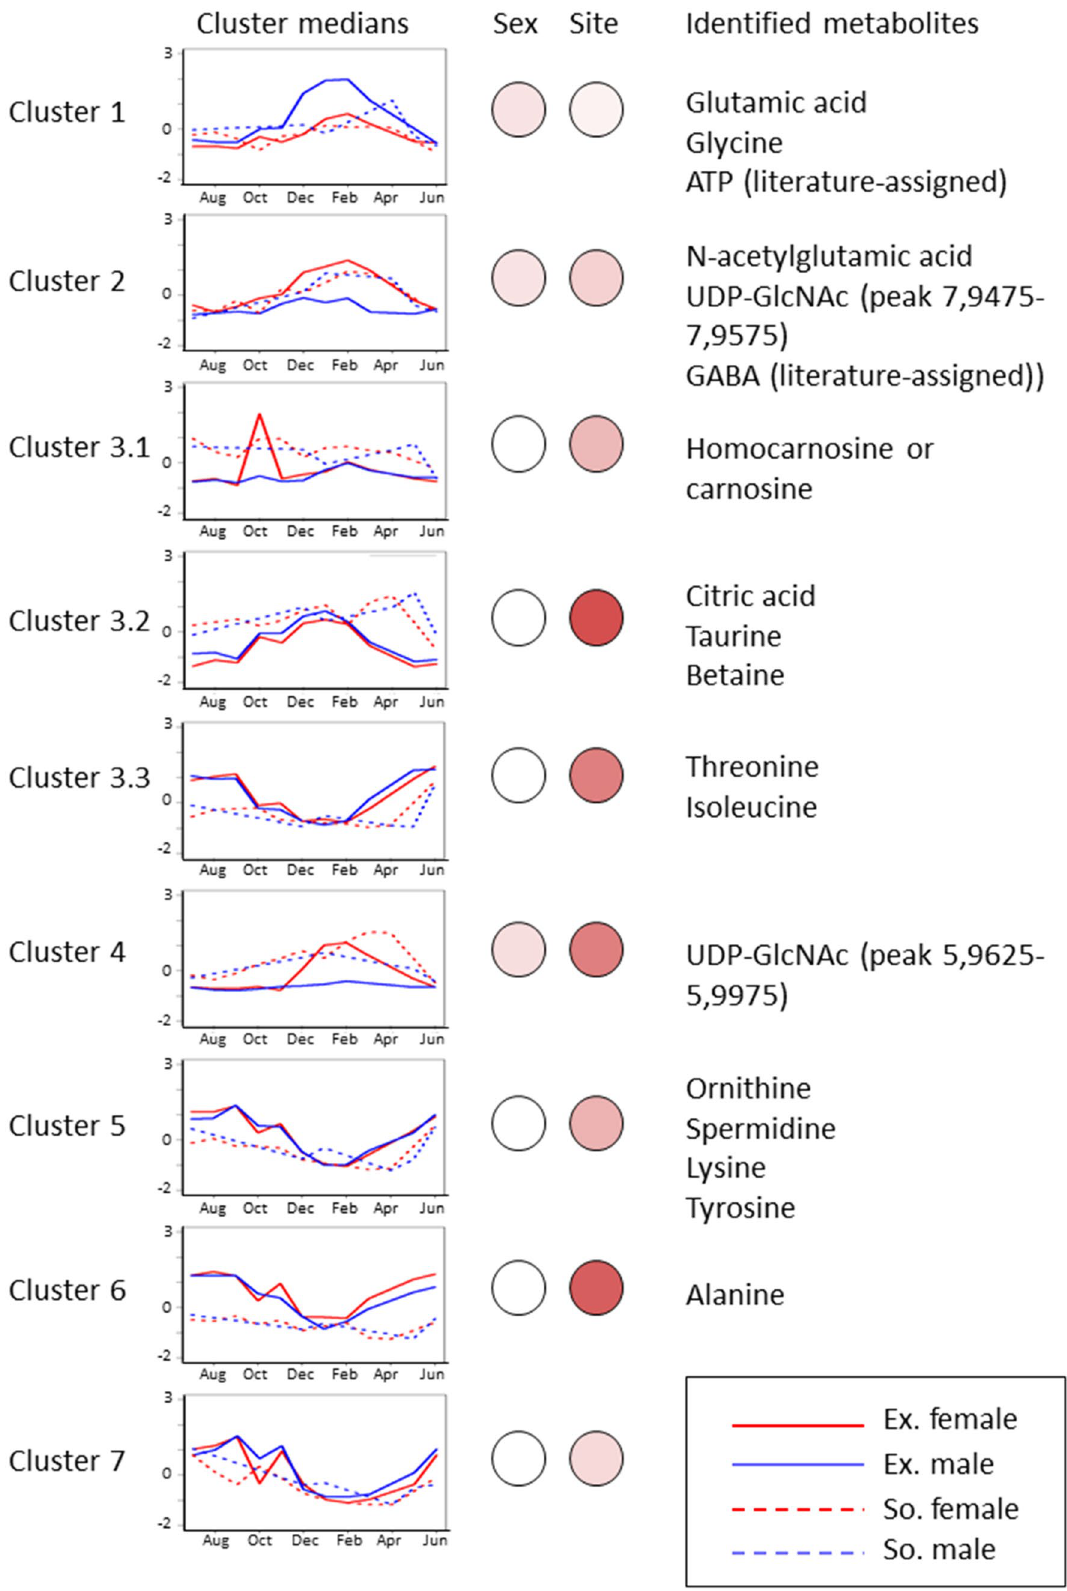
Figure 3. Clustering of metabolic profiles. Metabolite bins of Exmouth mussels have been clustered with HOPACH, a clustering tool that determines the number of clusters automatically. Cluster medians are used for visualization. The same Exmouth clusters are used to show cluster medians of Southampton samples. Female mussels are represented with red and males with blue, Exmouth with solid line and Southampton with dashed line. Percentage of significantly different (FDR 1e-8) bins in each cluster is shown by colour intensity. Putative metabolite identities are also